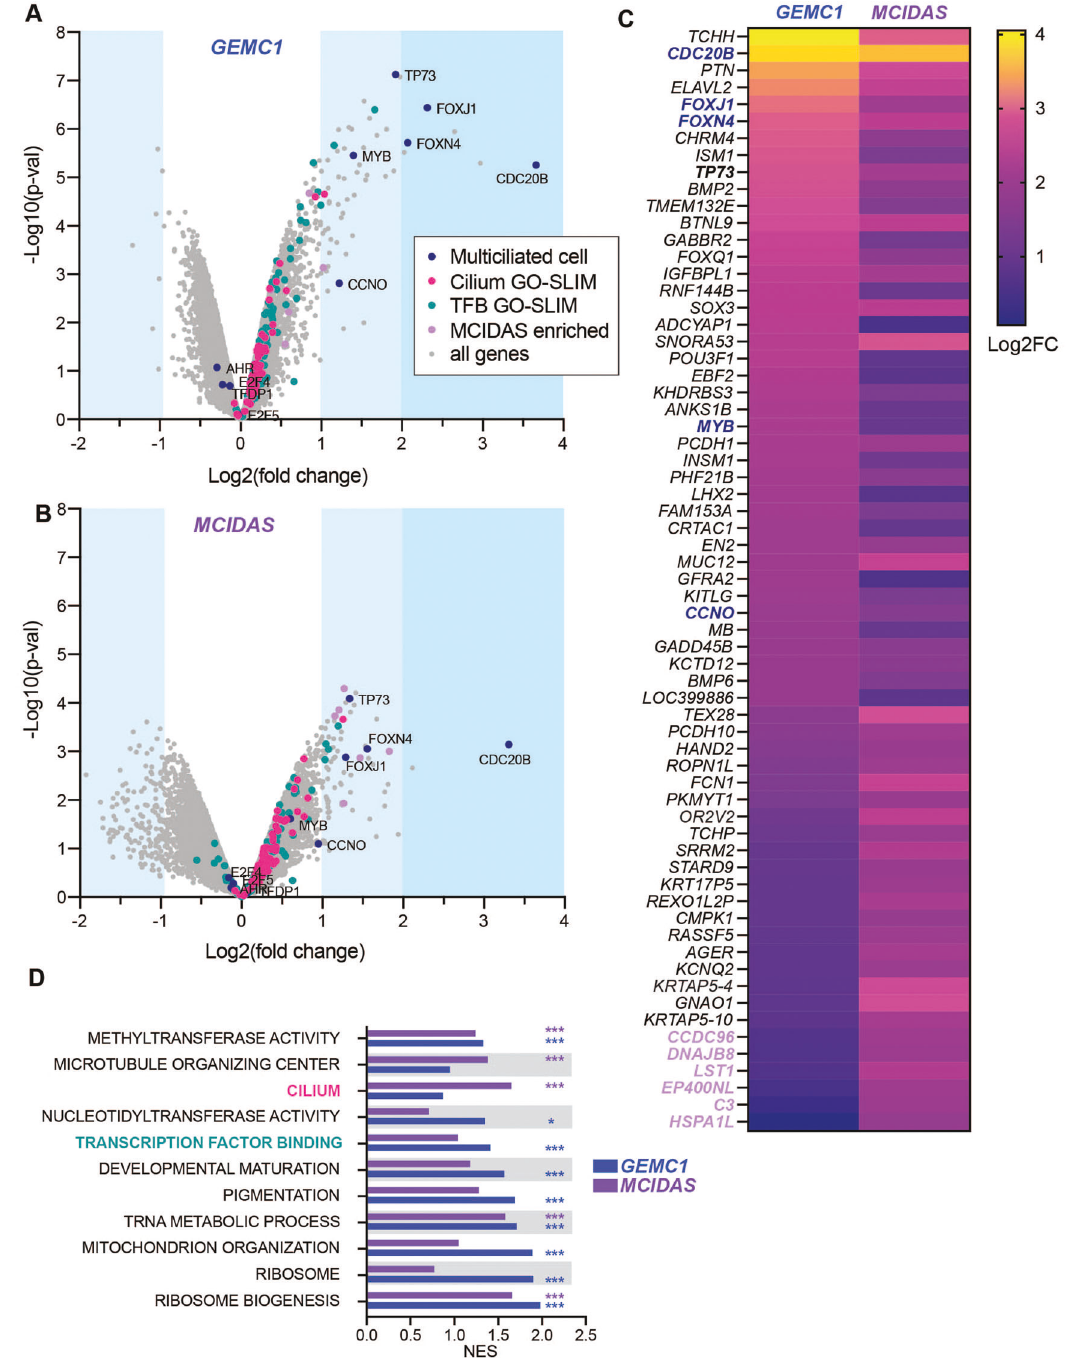
Fig. 1 GEMC1 and MCIDAS overexpression activates overlapping and distinct target genes. A Volcano plots (-Log10 p-value vs Log2 fold change) of microarray analysis of gene expression following transient transfection of GEMC1 and B MCIDAS in AD-293 cells ( n = 2 biological replicates). Genes in the Cilium and Transcription Factor Binding GO-SLIM categories (TFB = Transcription factor binding), genes implicated speci fi cally in multiciliated cells or genes enriched with MCIDAS over GEMC1 are indicated by color (legend in A, applies to A-D). Full details in Supplementary Tables S2 and S3. C Heatmap comparing expression (Log2 fold change = Log2FC) of most upregulated genes following either GEMC1 or MCIDAS expression. Color coding of gene categories is applied as in A . D Gene set enrichment analysis of the gene expression